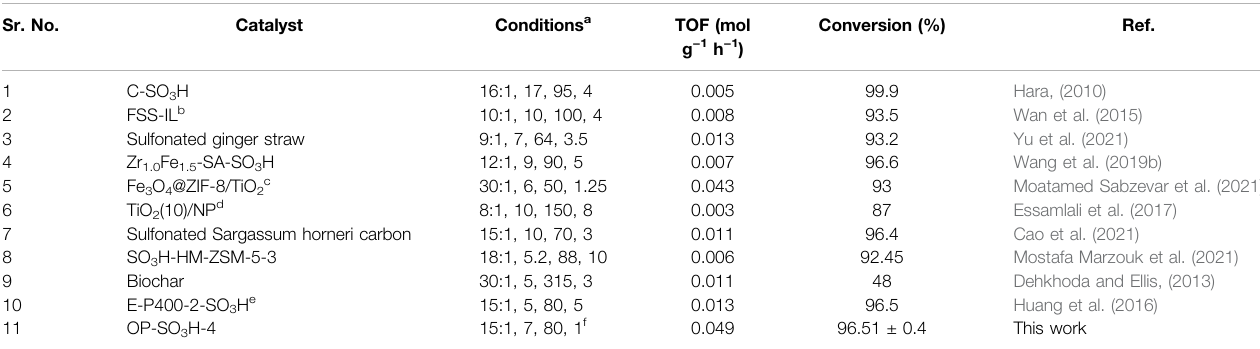
TABLE 3 | For the conversion of OA to biodiesel, the current catalyst was compared to a previously described catalyst. Sr.